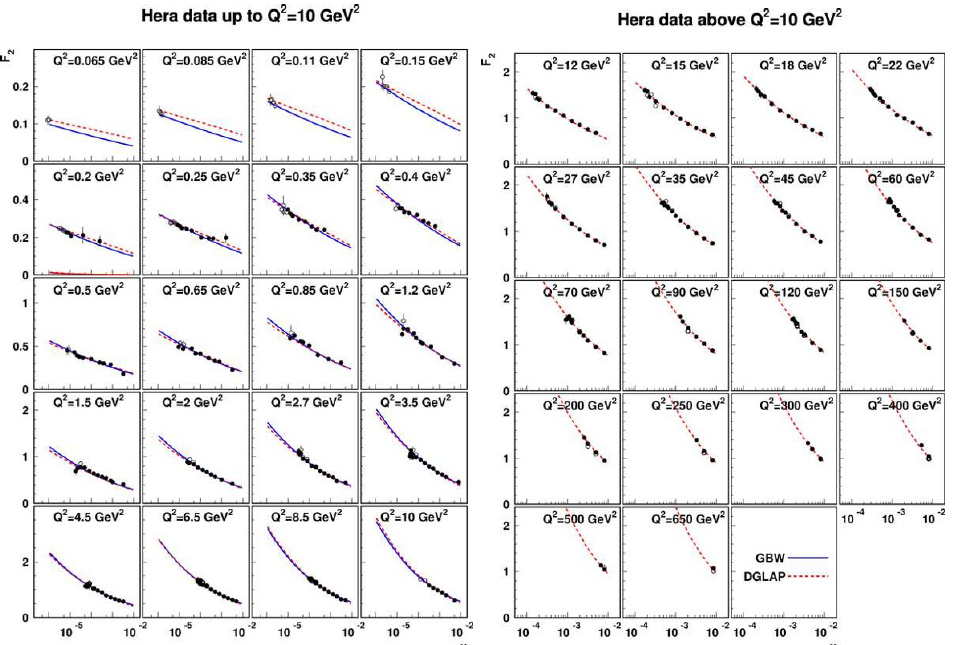
Figure 6 . Comparison of the HERA data from [1] up to Q 2 = 10 GeV 2 (left plot) and above (right plot) with the results from the GBW model (solid lines) and DGLAP improved model (dashed lines) with the parameters of Fit 2 in table 1 and 3, respectively. The GBW model lines are shown only in the region where the model was